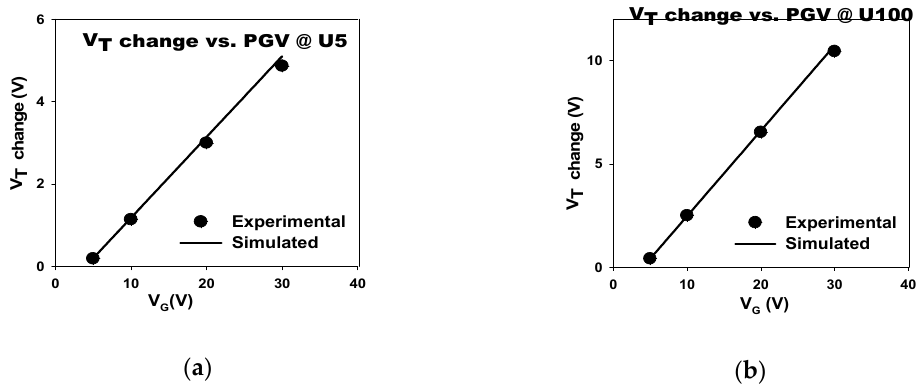
Figure 12. The model of V T as a function of PGV under fixed UV TD for an SAHAOS-T3 capacitor device ( a ) under UV TD 5 mW · s/cm 2 irradiation; ( b ) under UV TD 100 mW · s/cm 2 irradiation.